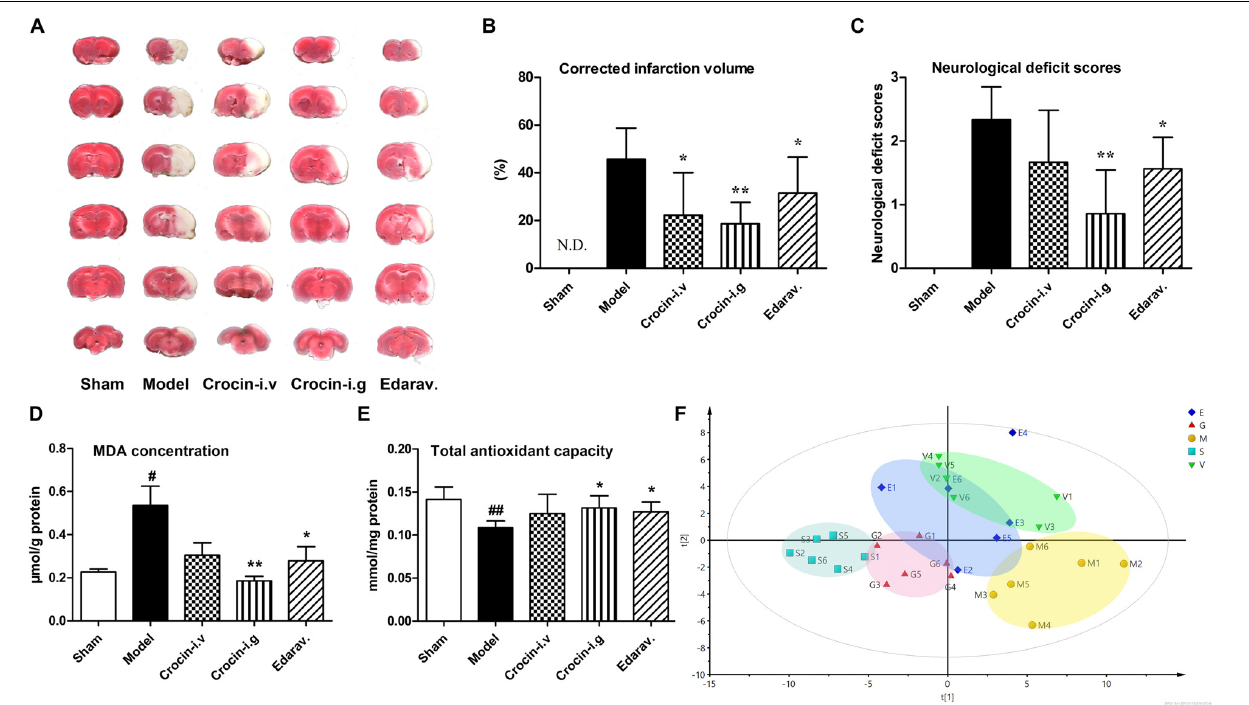
FIGURE 2 | Oral administration of crocin elicits superior cerebral-protective effects over intravenous administration. (A) Representative images of six serial sections from the same brain (top to bottom) prepared 24 h after MCAO and stained with TTC. The red areas represent normal brain tissues, and the white areas represent the infarct tissues. (B) Average infarction volumes corrected for brain edema as indicated ( n = 6), N.D., infarction not detected. ∗ P < 0.05, ∗∗ P < 0.01 vs. model group. (C) Neurological deficit scores in each group. ∗ P < 0.05, ∗∗ P < 0.01 vs. model group. (D) Malondialdehyde (MDA) and (E) total antioxidant capacity of brain tissues in the infarction region. Data are presented as the mean ± SD ( n = 6), # P < 0.05, ## P < 0.01 vs. sham group; ∗ P < 0.05, ∗∗ P < 0.01 vs. model group. (F) PLS-DA scores plots of brain tissues collected 24 h after MCAO. S, sham-operated group; M, model group; E, edaravone; G, crocin (i.g. administration) group; V, crocin (i.v. administration)